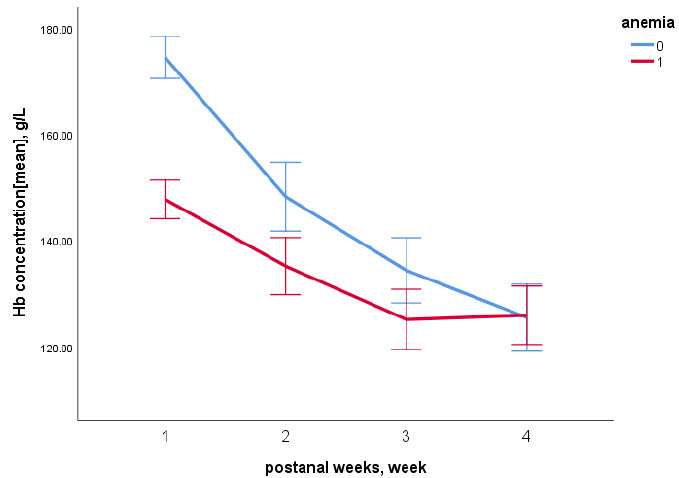
Figure 1. Changes of Hb concentration in the early anemia group and control group within 28 days after birth. Zero referred to the control group, and one referred to the early anemia group. Table 2. Comparison of NBNA results between the early anemia group and control group (N = 110).